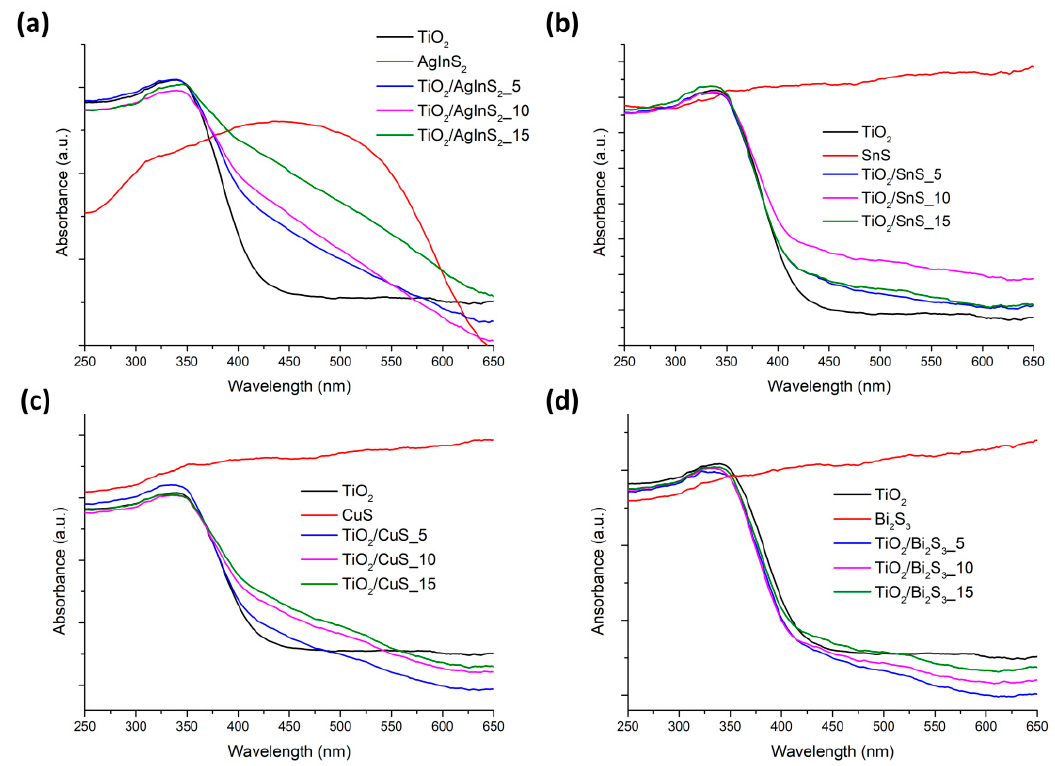
Figure 3. UV-Vis spectra for ( a ) TiO 2 , AgInS 2 and TiO 2 modified with AgInS 2 (5, 10, 15 wt%), ( b ) TiO 2 , SnS and TiO 2 modified with SnS (5, 10, 15 wt%), ( c ) TiO 2 , CuS 2 and TiO 2 modified with CuS (5, 10, 15 wt%), ( d ) TiO 2 , Bi 2 S 3 and TiO 2 modified with Bi 2 S 3 (5, 10, 15 wt%).